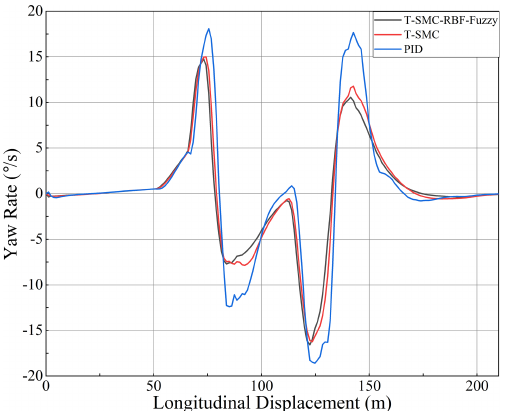
Figure 17. Trajectory tracking of different controllers.